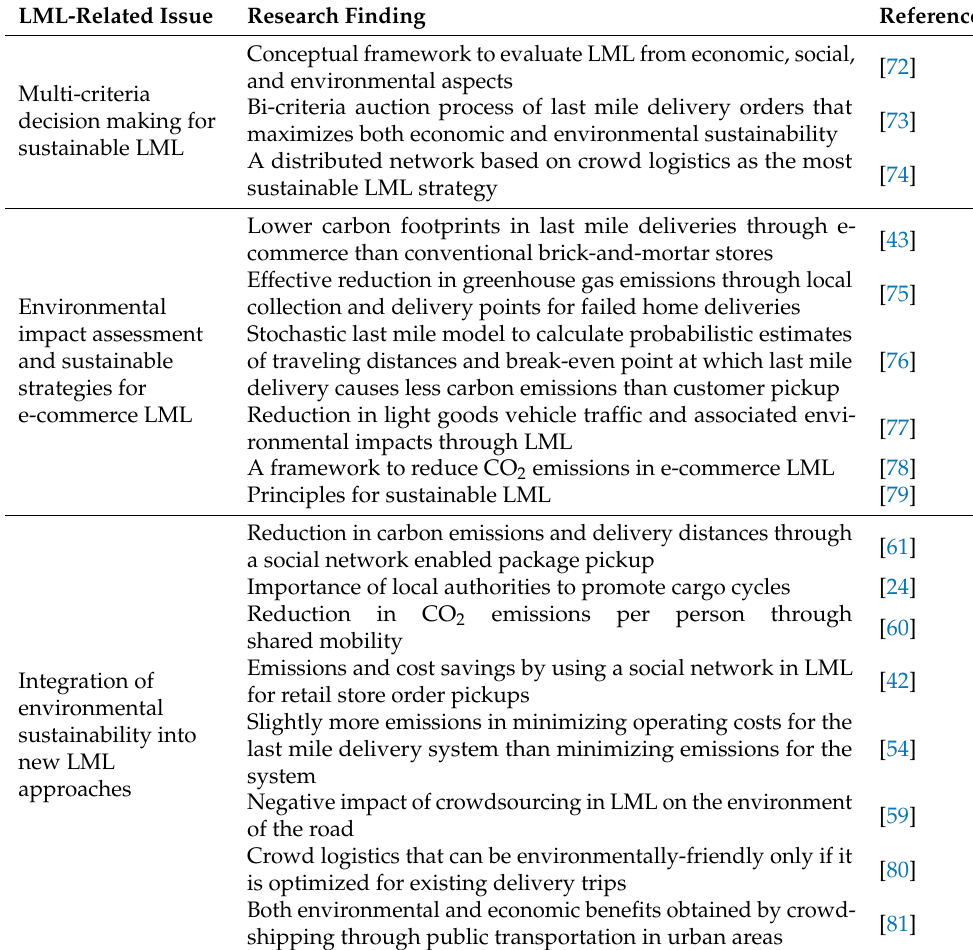
Table 5. LML-related issues and research findings: Environmental